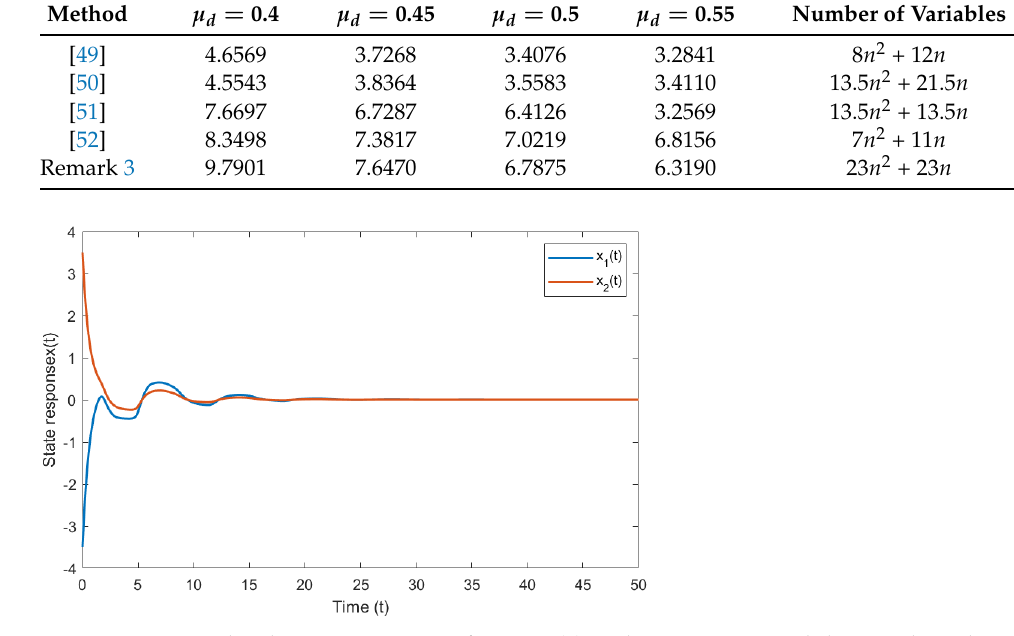
Figure 2. It provides the state response of system (4) under zero input and the initial condition [ − 3.5,3.5 ] . The interval time-varying delays are chosen as µ ( t ) = [ 6.3190 + 0.55 | sin ( t ) | ] , and the activation function is set as f ( ξ ( t )) = [ 0.3 tanh ( x 1 ( t )) ,0.8 tanh ( x 2 ( t ))] T